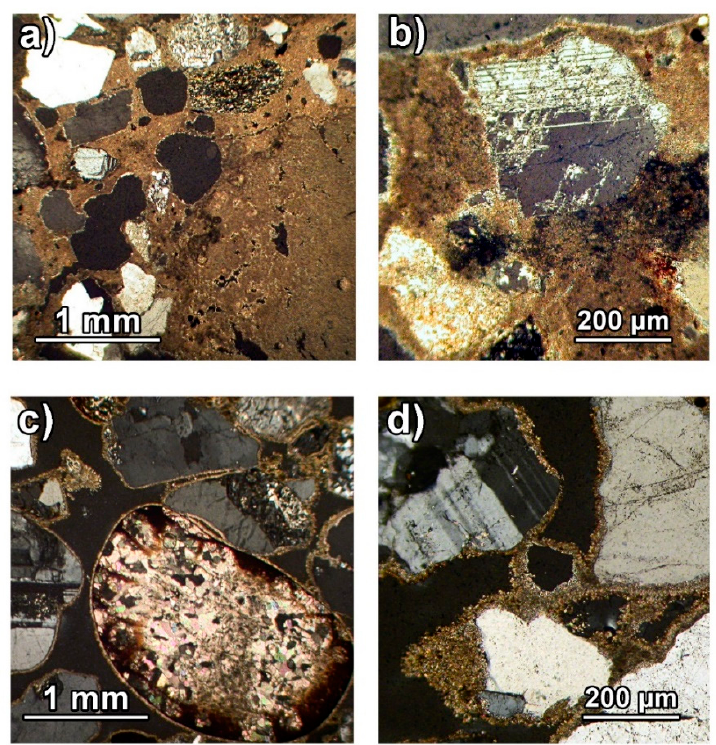
Figure 10. Comparison between the petrography of the sampled MAC-19018 feminine sculpture ( a , b ) and that of a beachrock lithology from a core drilled at the Barcelona port ( c , d ). Both samples show substantial intergranular space but in the archaeological sample this is more prominently filled with micritic-size cement. Composition for both samples is similar (including quartz, feldspars, and carbonatic components), the angularity of clasts is higher for the archaeological